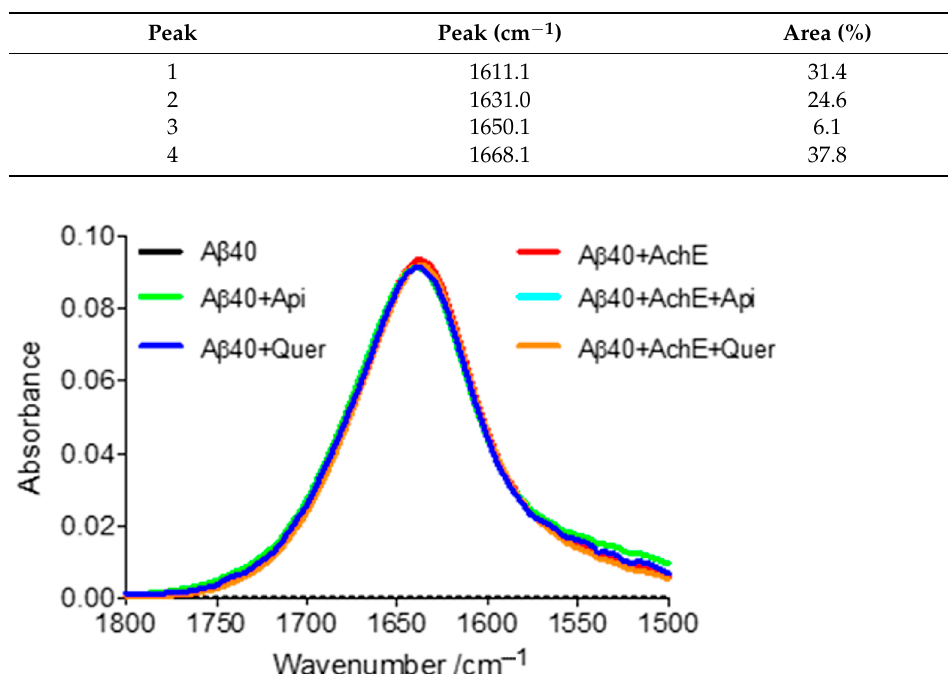
Table 4. Absorption peaks characterizing the secondary structure of A β 40, determined by FTIR spectroscopy.